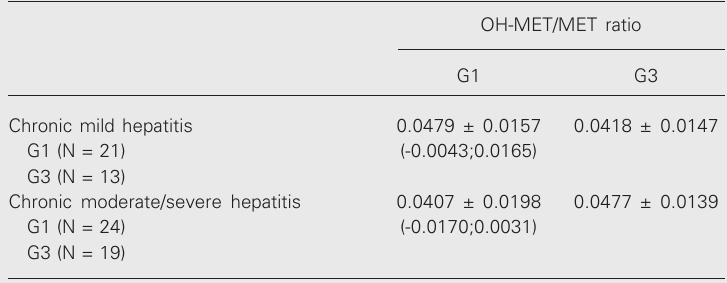
Table 2. Plasma hydroxy-metronidazole/metronidazole ratios according to genotype and histological